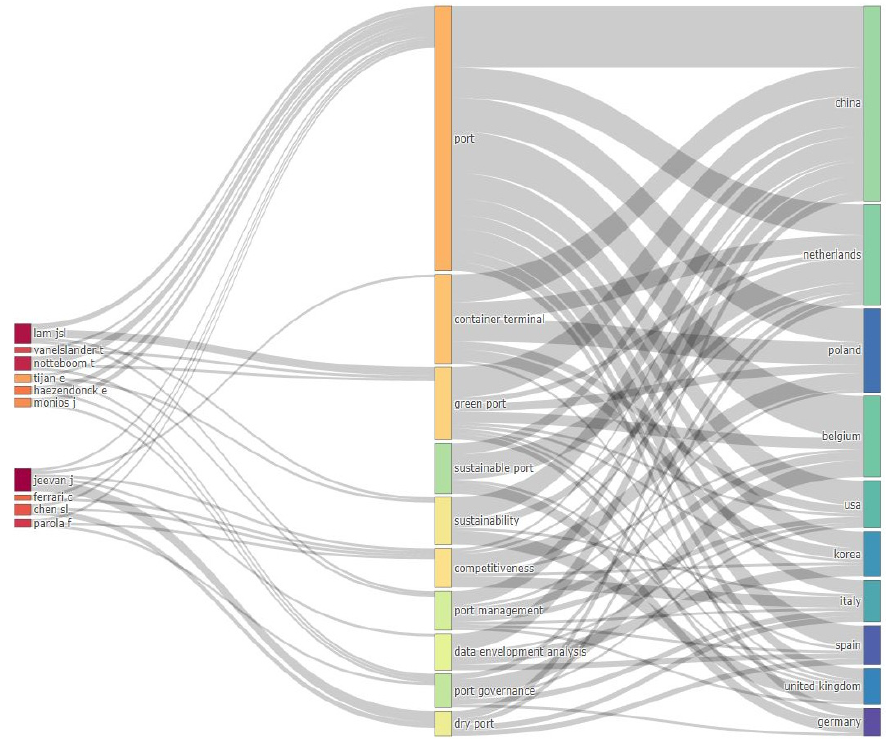
Figure 4. The three-fields plot regarding the interactions of the most influential scholars ( left ), scholar keywords ( center ), and countries ( right ).